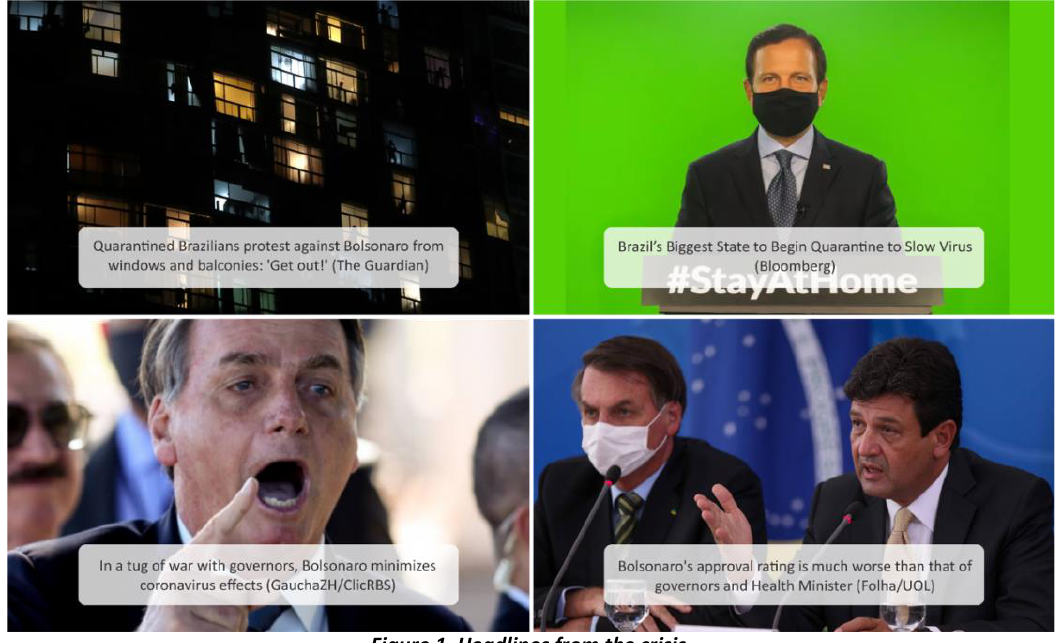
Figure 1. Headlines from the